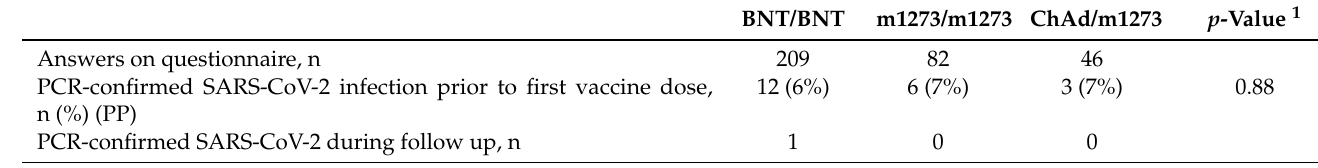
Table 1. Characteristics of the cohorts according to vaccine